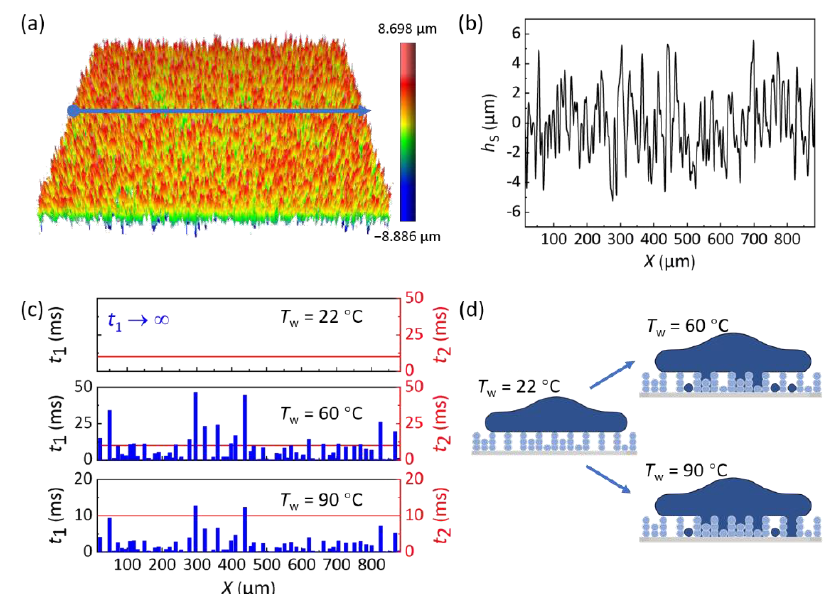
Figure 3. The relationship between surface textures and the formation of liquid bridges. ( a , b ) The texture height ( h s ) distribution at different locations ( X ) on the as-prepared HWRS. ( c ) The relationship between t 1 and t 2 on different locations of HWRS. ( d ) Schematic of the formation modes of liquid bridge at different T w .